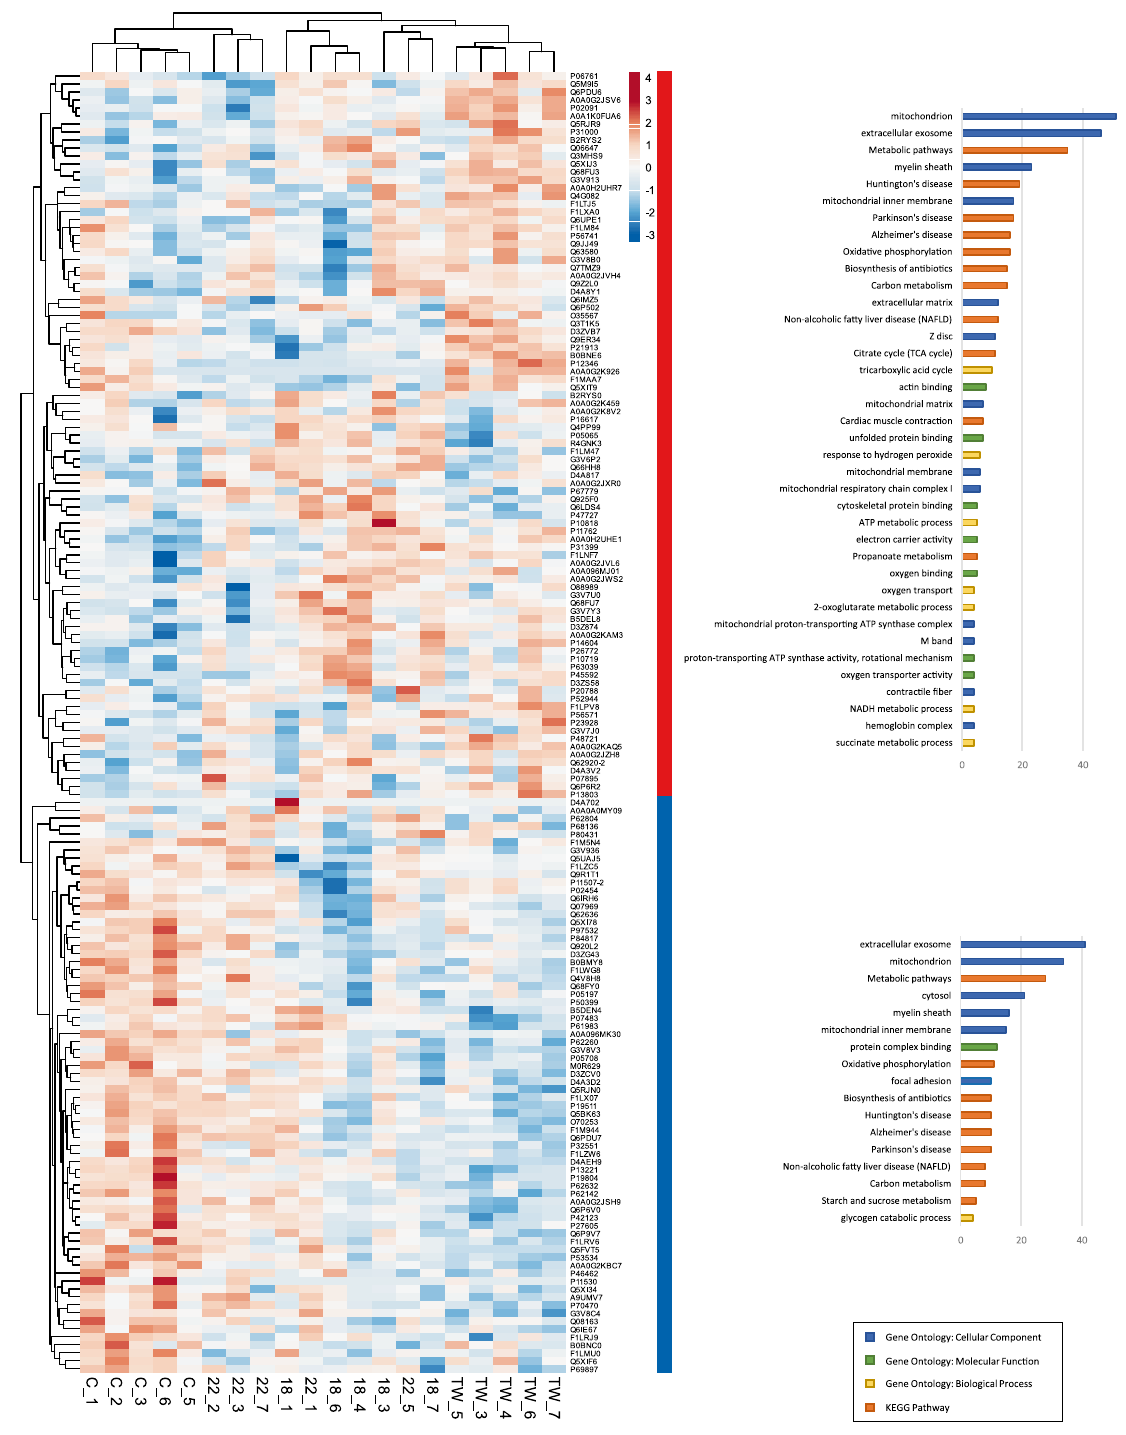
Figure 1. Heatmap of median protein concentrations in samples for proteins with a statistically significant concentration change in at least one of the considered comparisons to the control group ( p value < 0.05 in a t-test). Protein lists from two main row clusters (designated by red and blue colors) were subjected to functional analysis, and the results are presented on charts, showing numbers of proteins assigned to significantly enriched terms with a Bonferroni correction adjusted p value <